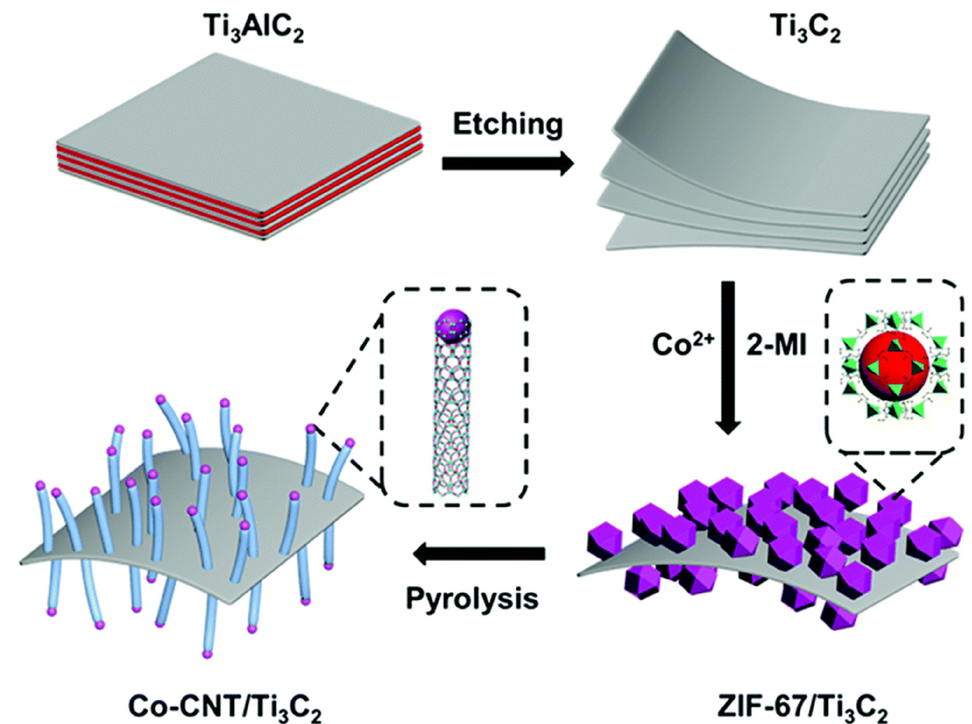
Figure 10. Schematic synthesis of Co-CNT / Ti 3 C 2 . Reprinted with permission from reference [97]. Copyright (2018) Royal Society of Chemistry.